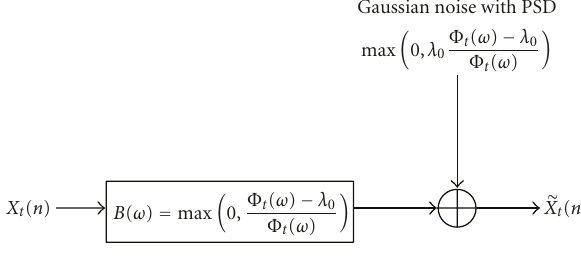
Figure 3: The forward channel representation.